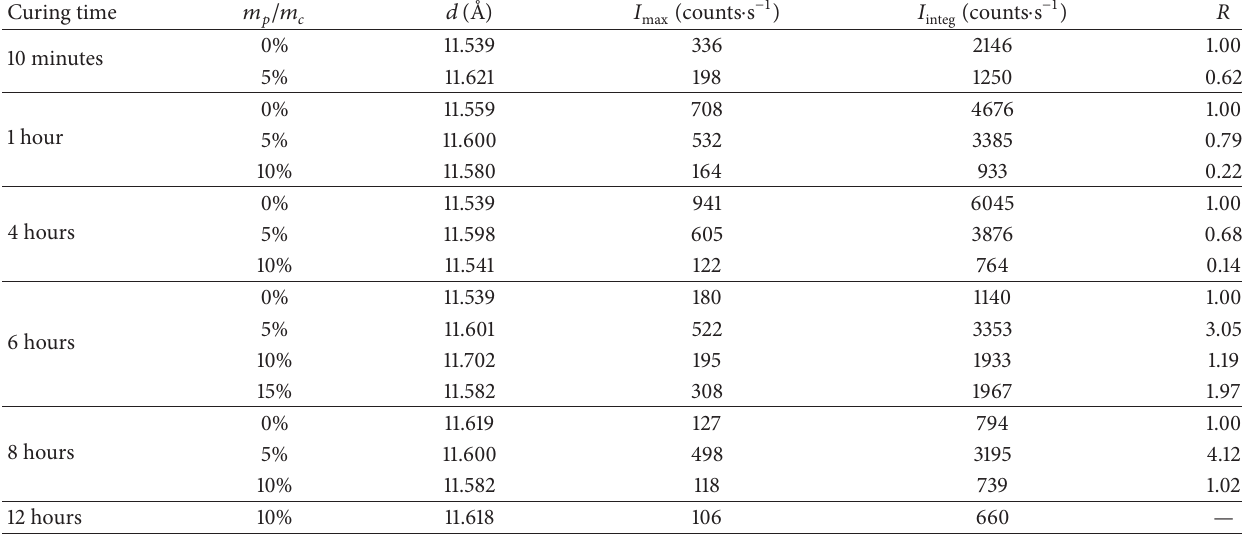
AH in the pastes with SAE 4 13